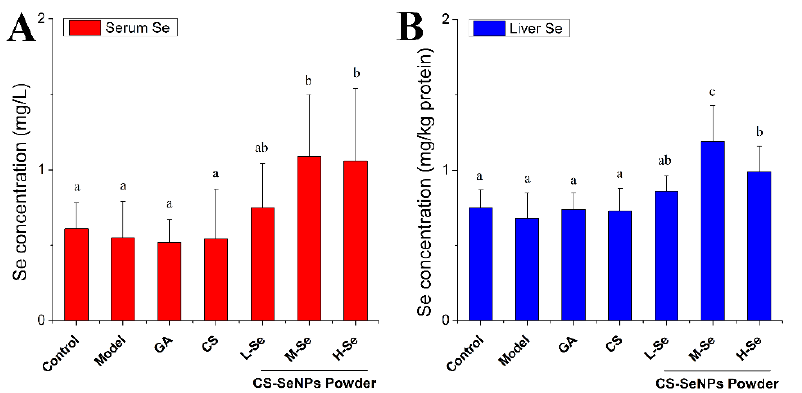
Figure 6. ( A ) Serum Se concentration and ( B ) hepatic Se level in KM mice. The administration modalities in each group are shown in Table 1. a–c Means within a panel with different letters differed significantly ( p < 0.05).